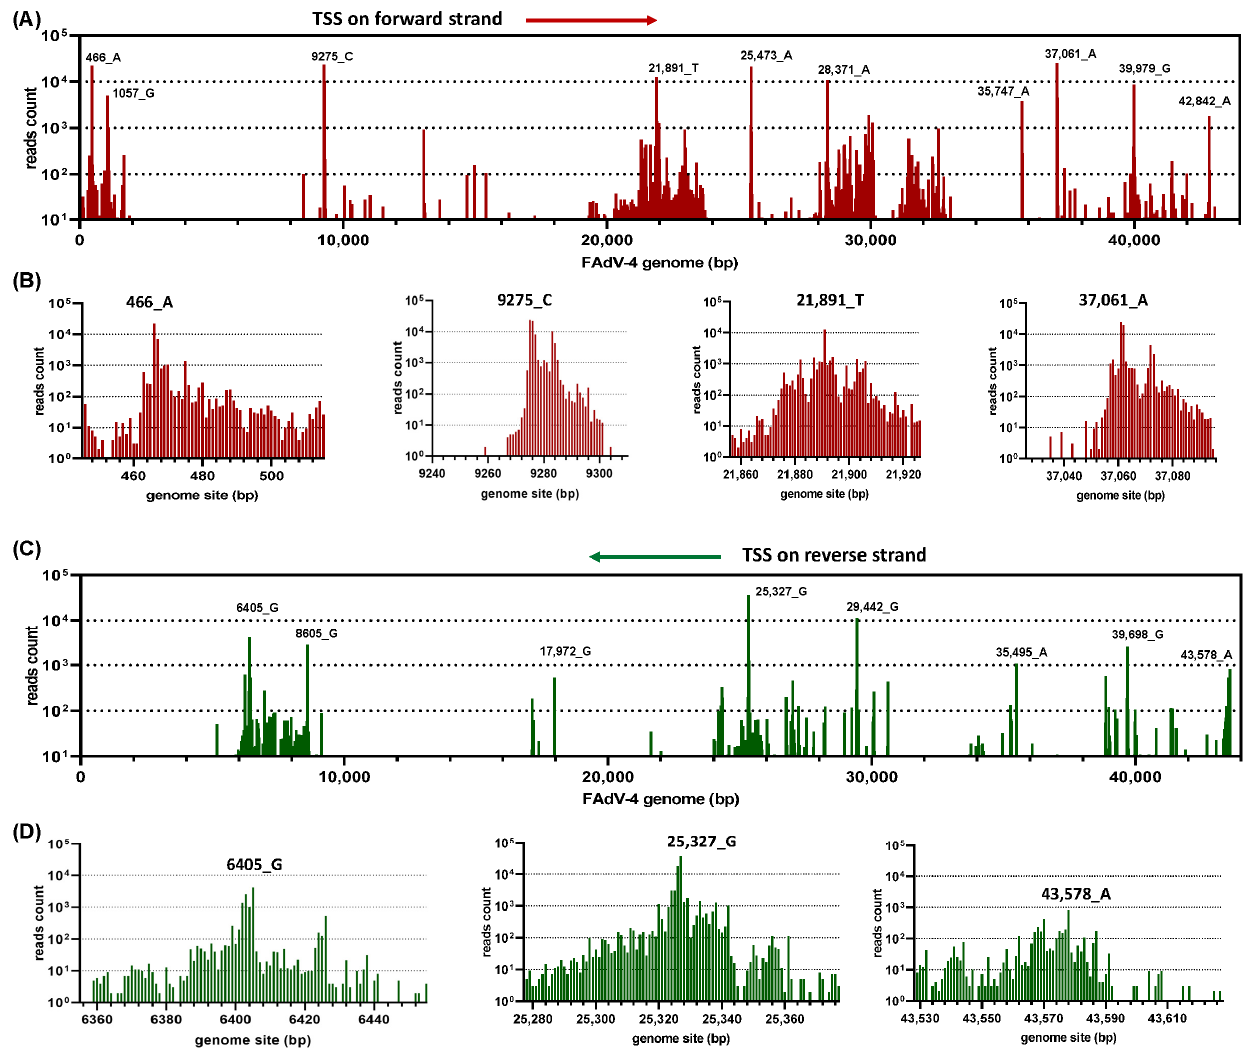
Figure 1. Determination of transcription start sites (TSS) in the FAdV-4 genome. RNA was extracted from FAdV-4-infected chicken LMH cells and subjected to nanopore PCR-cDNA sequencing. Reads originated from the genomes of host cells and were filtered. The remaining full-length cDNA sequences were corrected using Illumina RNA-seq data as the reference and then mapped to the FAdV-4 genome (GenBank MG547384). The resulting sequence alignment/map (SAM) file was processed by a previously published Perl script (classify_transcripts_and_polya_segmented.pl). The start site of each read was collected and expressed as the copy number of reads at each FAdV-4 genome position. ( A ) Read-start sites on the forward strand of the whole virus genome. ( B ) The read-start sites in some representative regions on the forward strand were shown at single-nucleotide resolution. ( C ) Read-start sites on the reverse strand of the whole virus genome. ( D ) The read-start sites in some representative regions on the reverse strand were shown at single-nucleotide resolution.